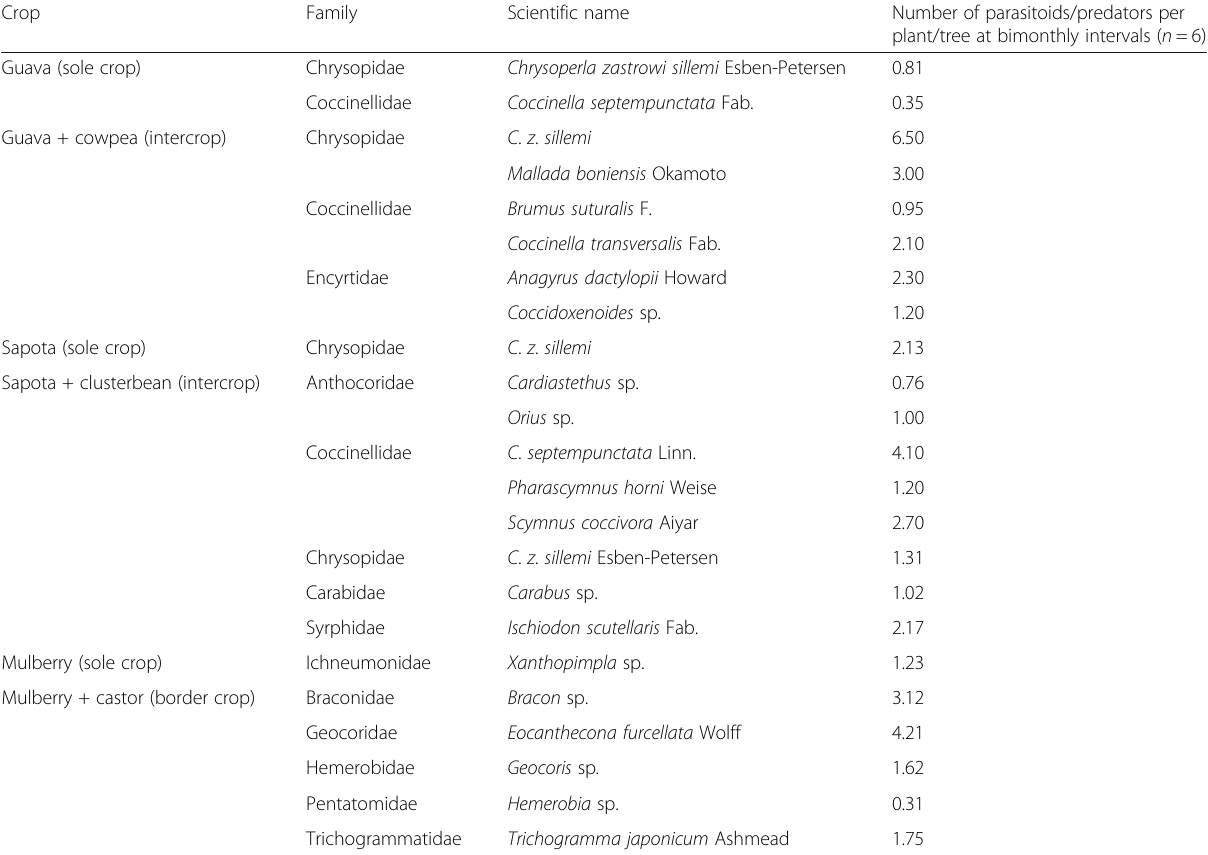
Table 1 Parasitoids and predators recorded in sole and diversified ecosystems at Kanakapura district in Karnataka, India, during 2016 – 2017 Crop